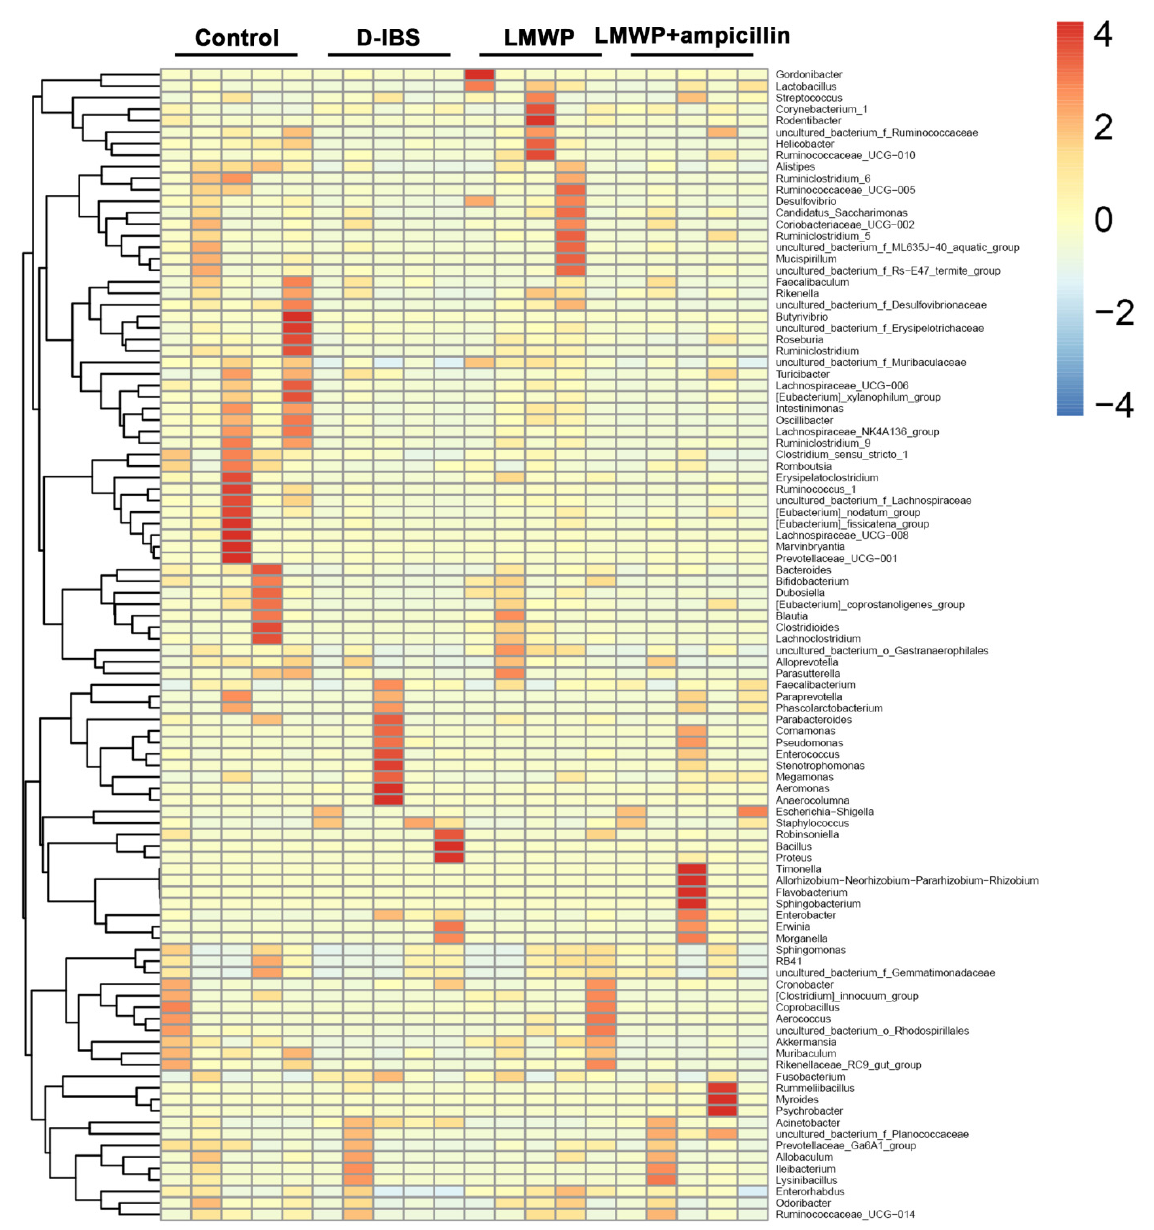
Figure 9. Heatmap of the gut microbiota at the genus level. Collectively, these findings indicated that treatment with LMWP (S3-3) from larvae of Musca domestica reversed D-IBS-induced dysbiosis of the gut microbiota. In comparison to the LMWP group, the LMWP + ampicillin group induced a decrease in Bacteroidetes and Verrucomicrobia but increased Proteobacteria at the phylum level (Figure 10A–C). The LMWP + ampicillin group induced a decrease in g_uncultured_bacterium_f_Muribaculaceae , Akkermansia , Lachnospiraceae_NK4A136_group and Lachnoclostridium but an increase in Acine- tobacter at the genus level in comparison to the LMWP group (Figure